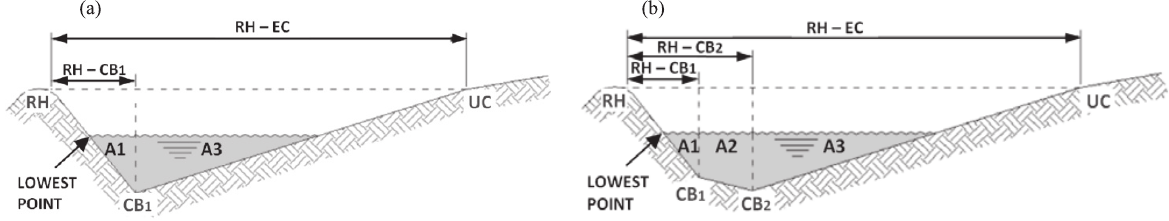
figure 2. cross section areas of triangular-shaped terrace channels (a) and trapezoidal-shaped terrace channels (b). source: Pruski (2009).